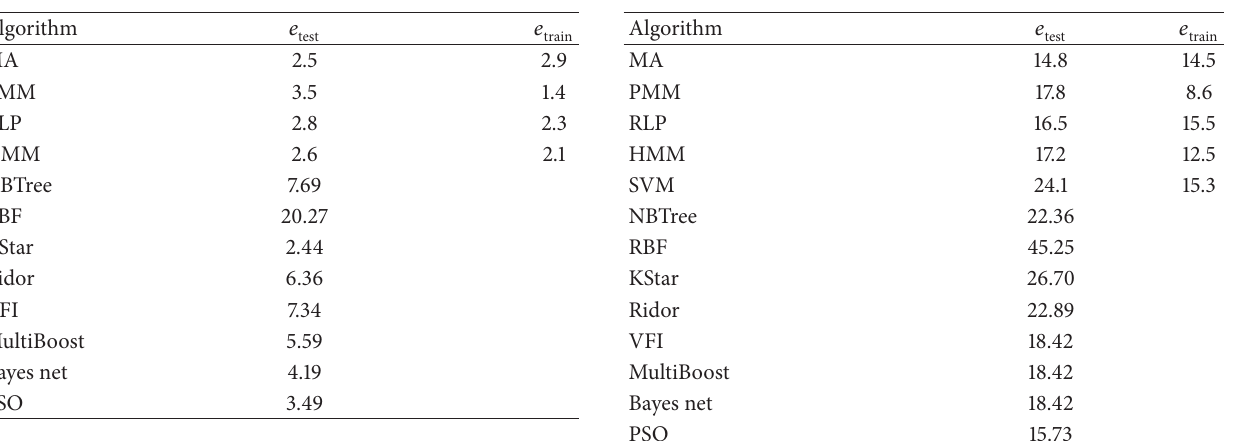
Table 3: Results in the breast cancer database.